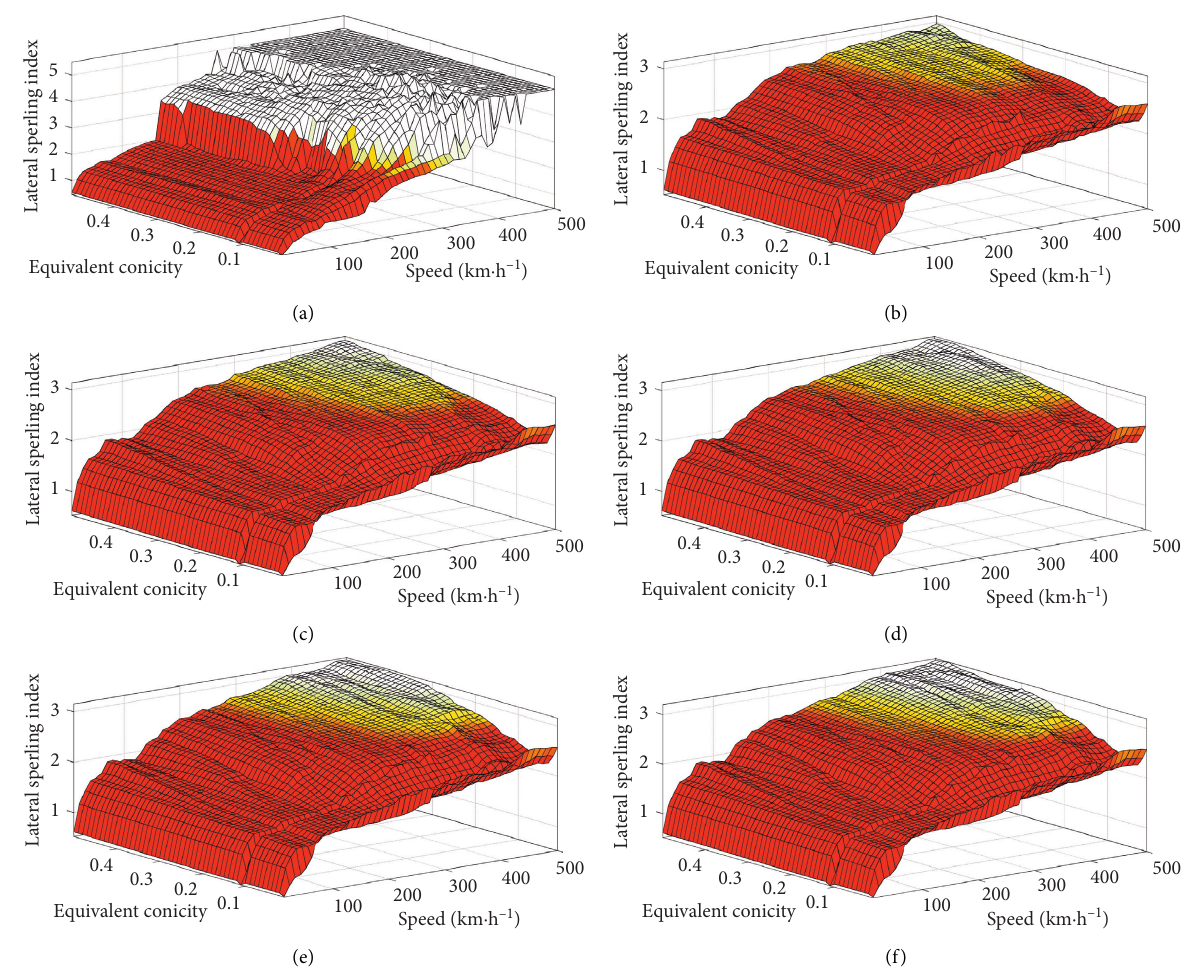
Figure 14: Vehicle ride quality space with joint stiffness of 70MN · m − 1 and additional stiffness of 8 MN · m − 1 . (a) c � 0. (b) c � 110kN · s · m − 1